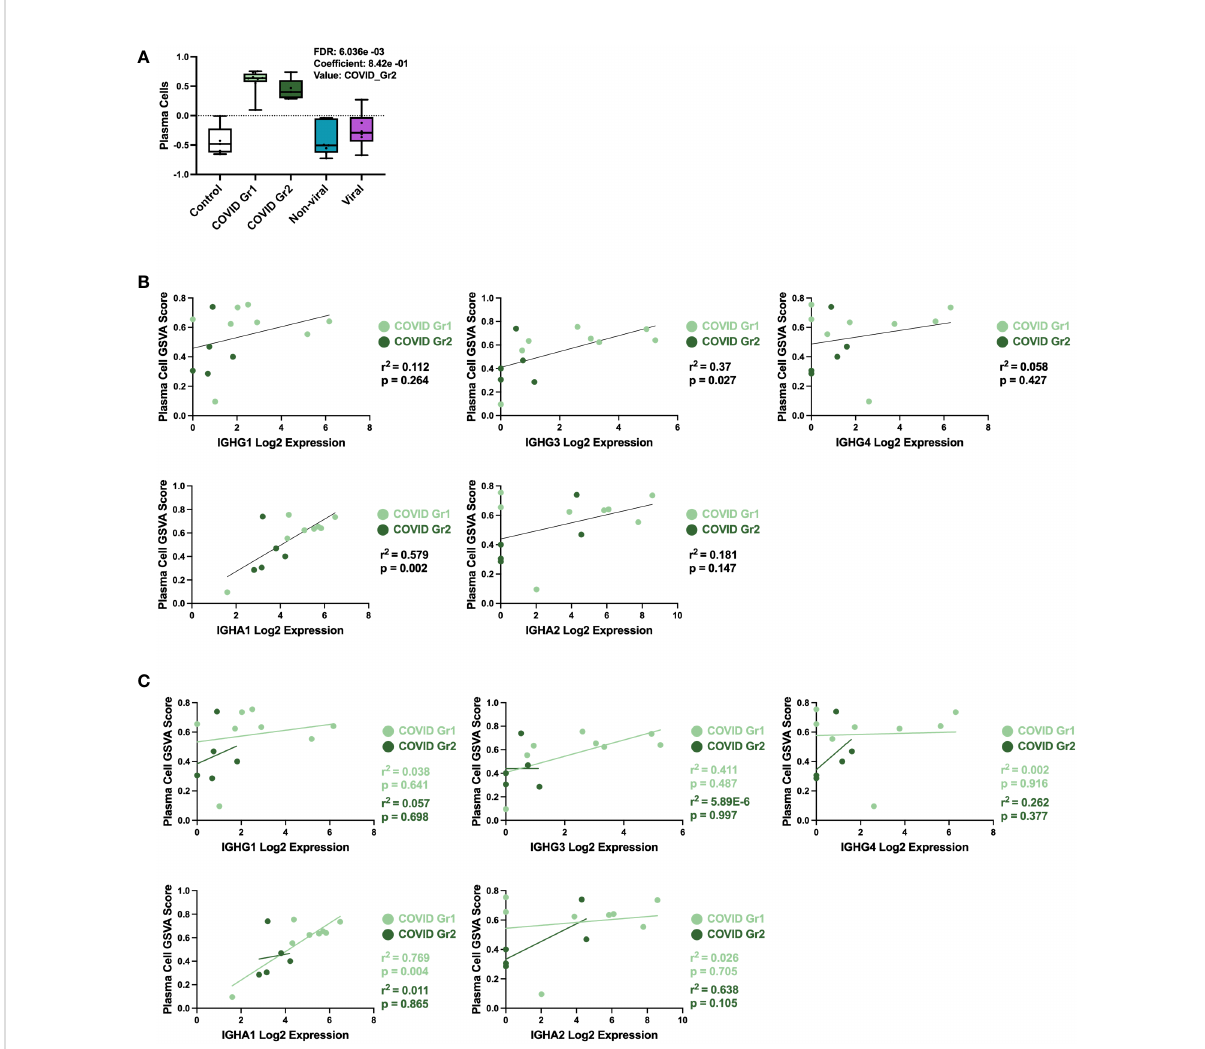
FIGURE 4 Speci fi c plasma cell populations are characteristic of COVID-19-induced AHRF. (A) Multivariable linear regression analysis boxplots depicting signi fi cant correlation of the PC gene signature GSVA scores with ICU patient cohort. (B, C) Linear regression between PC GSVA scores and Ig heavy chain isotype